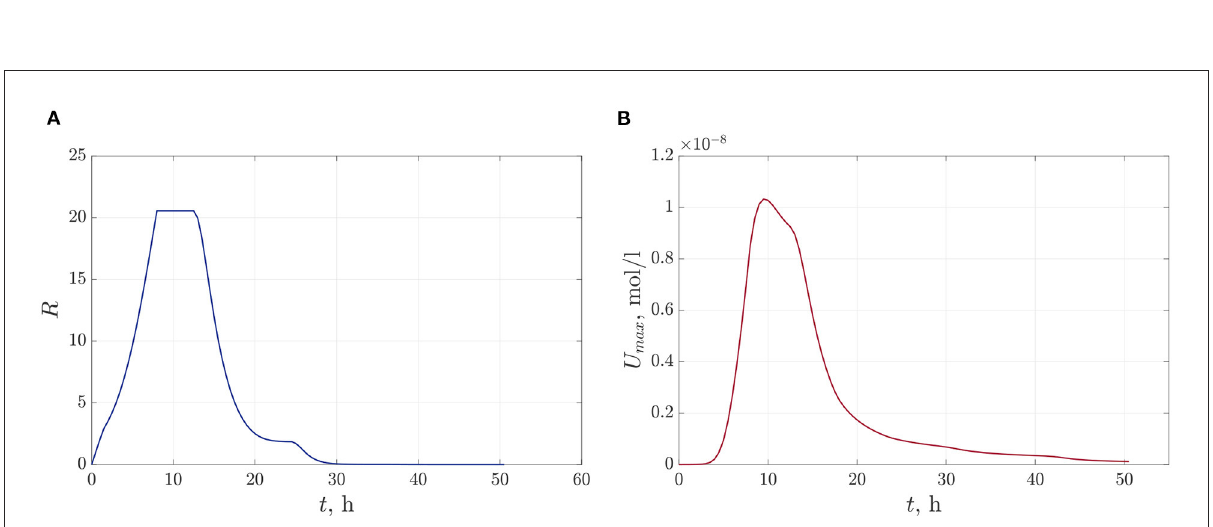
FIGURE9 The time dependence of total linear size of bacterial colonies— (A) and the dynamics of the maximum values of the AHL concentration— (B) at the multiple antibiotic treatment.